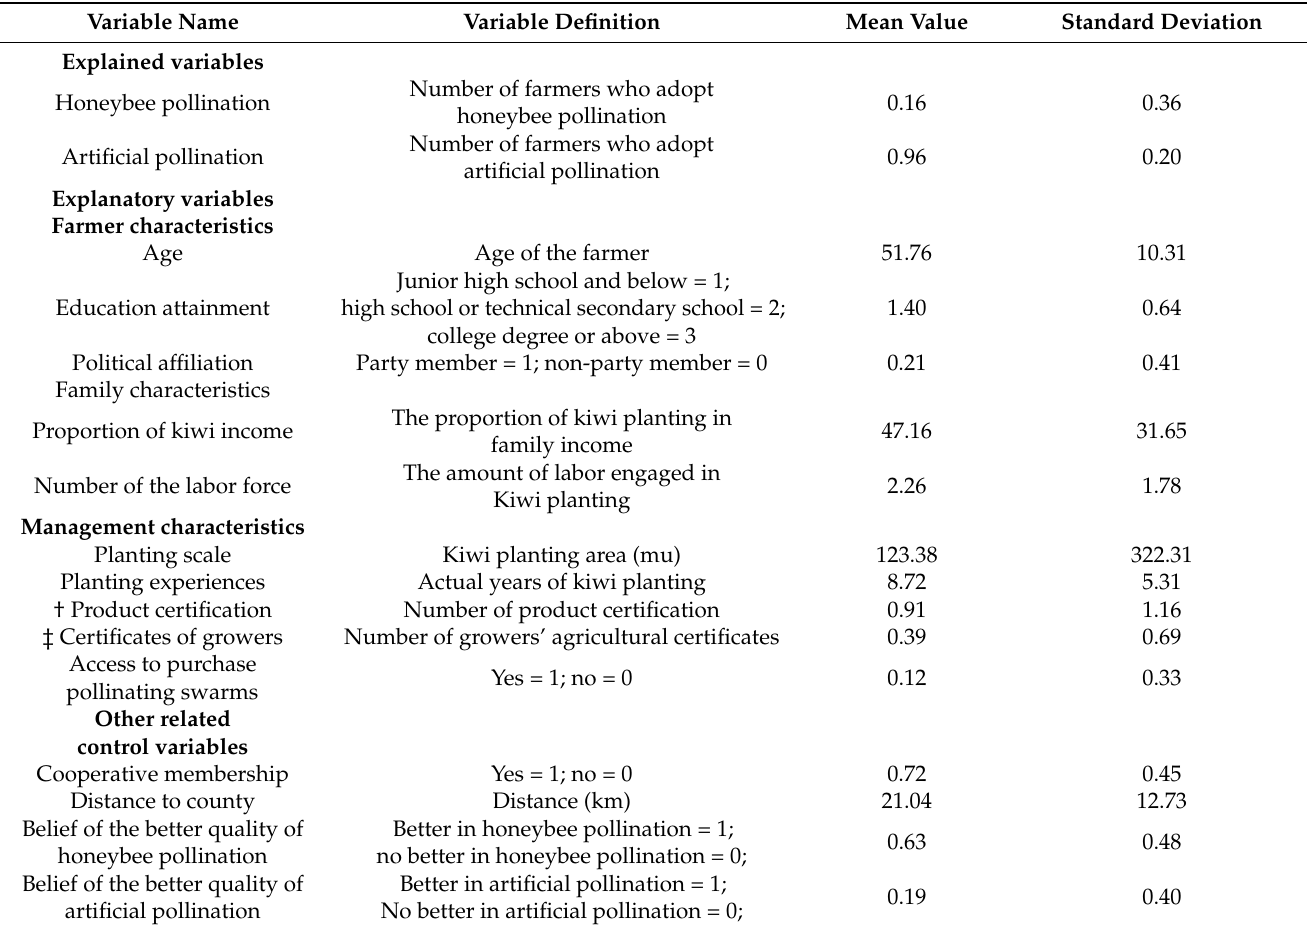
Table 1. Descriptive statistics of